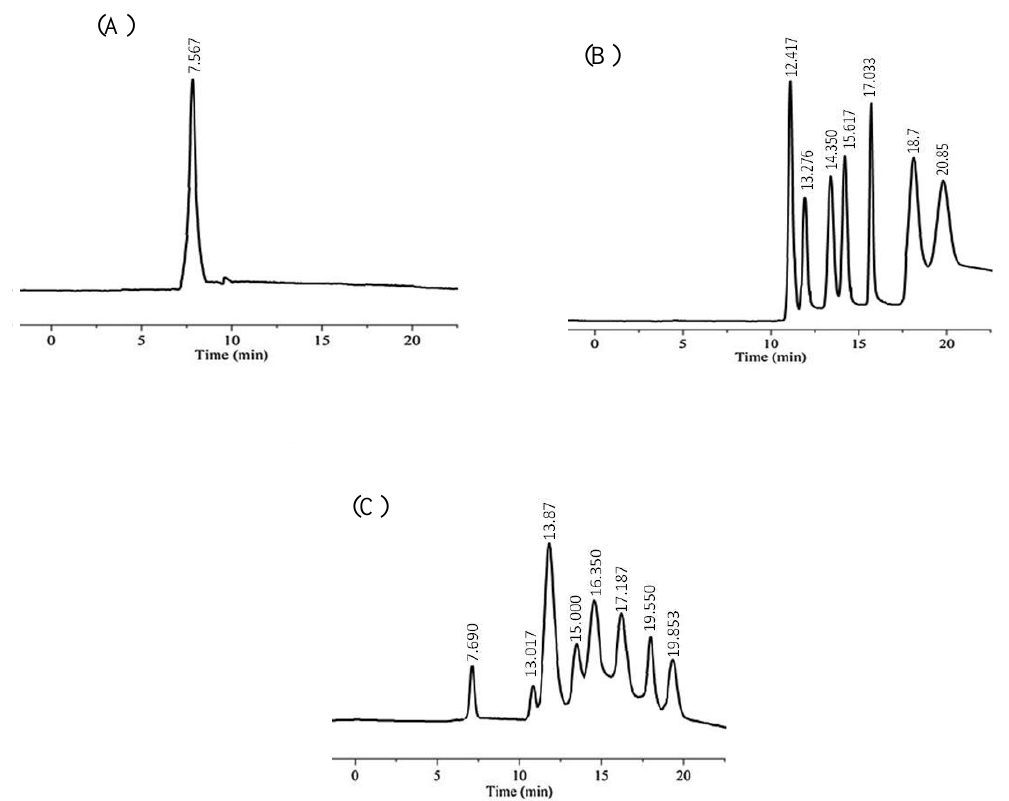
Figure 7. HPLC Profiles of the starch hydrolysis products of amBP under E/S ratio of 10U/g. ( A ) HPLC profile of a solution containing 10 g/L soluble starch. ( B ) Standards HPLC profile of a solution containing 8 g/L glucose and 5 g/L for each of maltose, maltotriose, maltotetraose, maltopentaose, maltohexaose (DP6), and maltoheptaose (DP7). ( C ) HPLC profiles of the starch hydrolysis products relative to amBP.